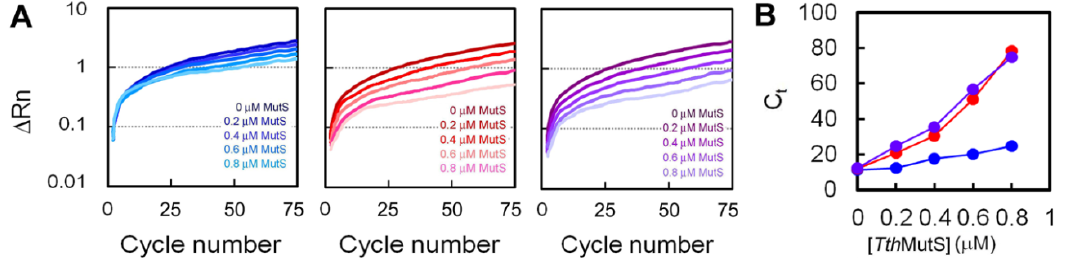
Figure 2. Effects of Tth MutS on amplification of an 80-bp template by using real-time PCR. ( A ) An 80-bp perfectly matched dsDNA was amplified by AmpliTaq Gold DNA polymerase by using perfectly matched (left), GT-mismatched (middle) or unpaired T-containing (right) primers in the presence of 0, 0.2, 0.4, 0.6, 0.8 or 1.0 μ M Tth MutS. The change in fluorescence ( ∆ Rn) was plotted against the cycle number; ( B ) The threshold ) was determined and plotted against the Tth MutS concentration. Blue, red and cycle ( C t purple circles indicate amplification by using perfectly matched, GT-mismatched and unpaired T-containing primers, respectively. All experiments were repeated three times. Bars indicate standard